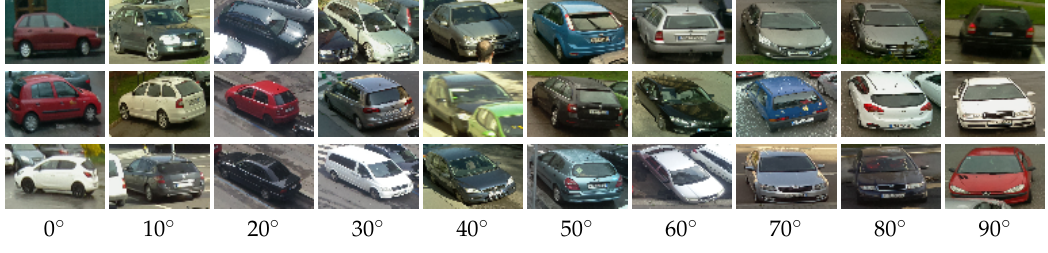
Figure 4. Groups of training